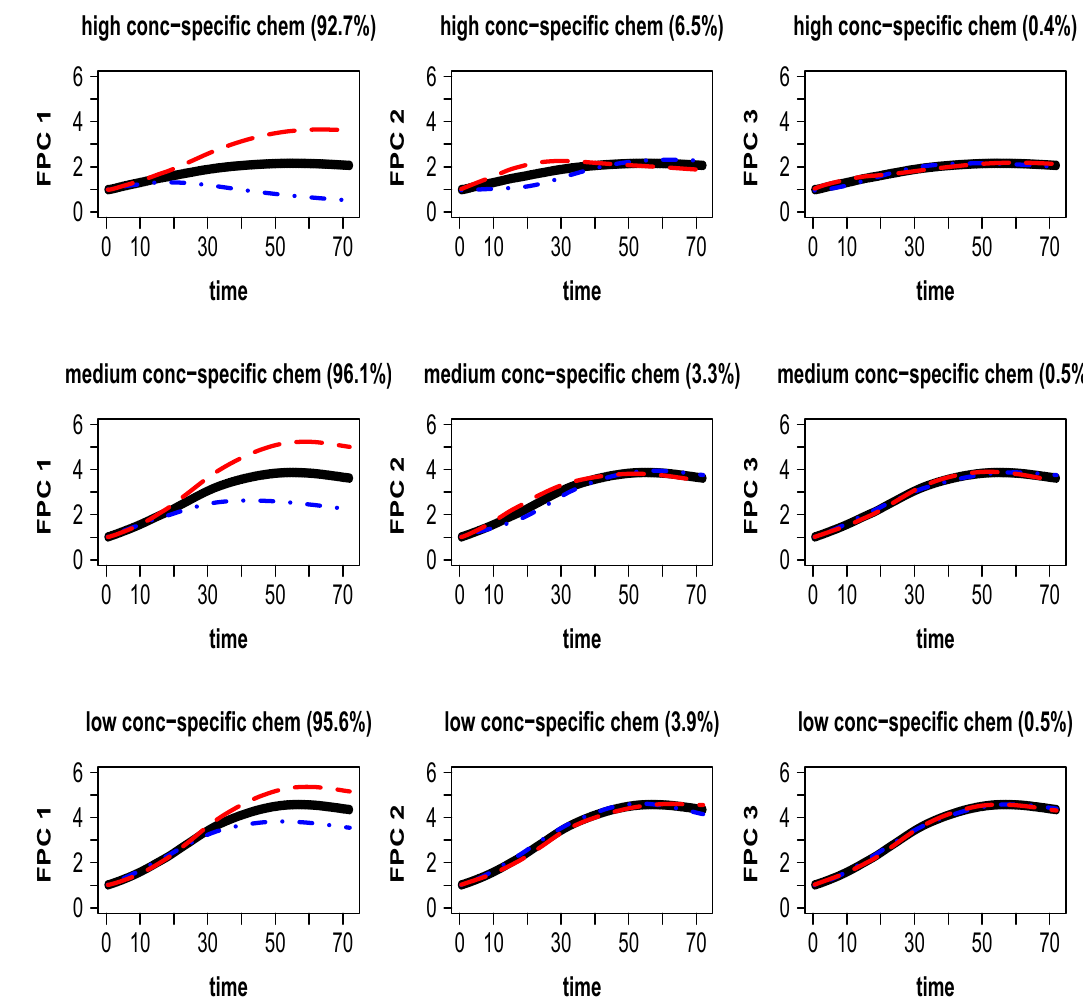
Figure 3. Concentration level-specific means (black, -) plus (red, –) and minus (blue, -.-) a suitable multiple of the first three principal components of B τ c . The respective proportion of variability induced by chemical effects within concentration is given in